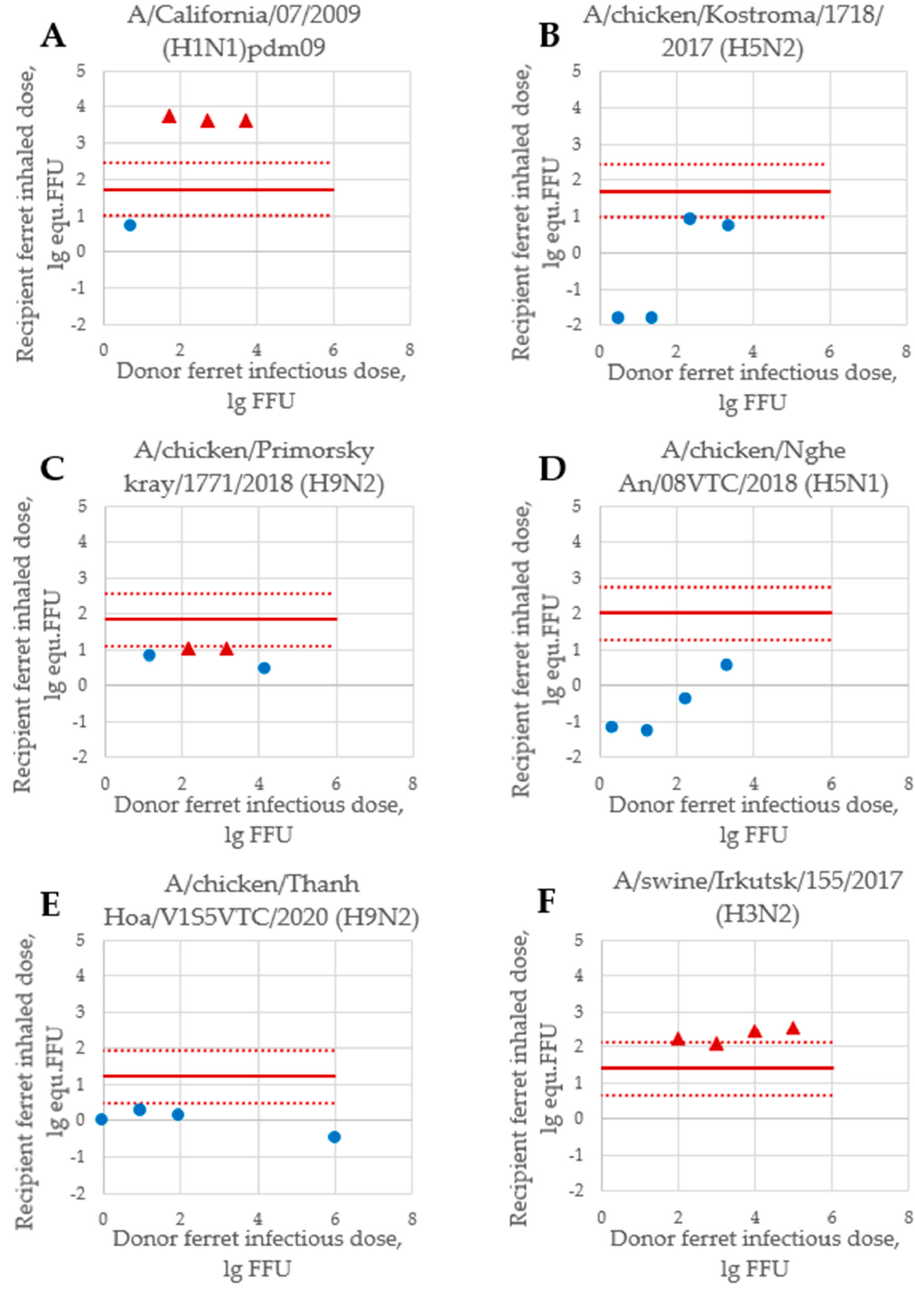
Figure 3. Effect of IID in donor ferrets on estimated AID inhaled by recipients, for donor ferrets infected with influenza virus strains: ( A ) A/California/07/2009 (H1N1)pdm09, ( B ) A/chicken/Kostroma/1718/2017 (H5N2), ( C ) A/chicken/Primorsky Krai/1771/2018 (H9N2), ( D ) A/chicken/Nghe An/08VTC/2018 (H5N1), ( E ) A/chicken/Thanh Hoa/V1S5VTC/2020 (H9N2), ( F ) A/swine/Irkutsk/155/2017 (H3N2). The X axis—IID in donor ferrets expressed in lg FFU. The Y axis—AID inhaled by recipient ferrets calculated as lg FFU-equivalents based on RT-PCR of the nasal washings from the analytical aerosol filter. Red line indicates AID 50 for each strain. Dotted red lines indicate 95% confidence interval. Red triangle indicates AID when recipient ferrets have become infected. Blue solid dots indicate AID when recipient ferrets have not become